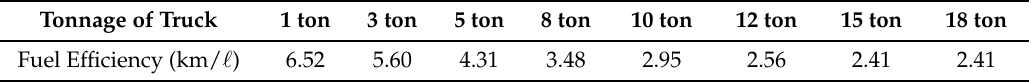
Table 5. Average mileage of a cargo truck for each tonnage of load, derived from a study on plans for reducing economic freight transportation distance of mass transportation means, by Korea Transport Institute (2011) [42].